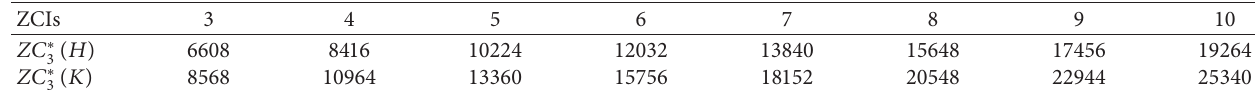
for H and K networks on dimensions 3 ≤ n ≤ 10. 3